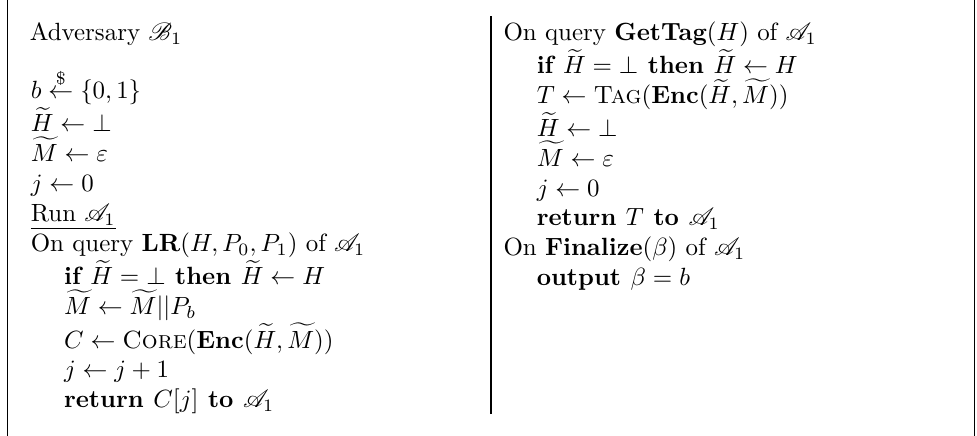
Figure 6: Adversary B 1 for the proof of Theorem